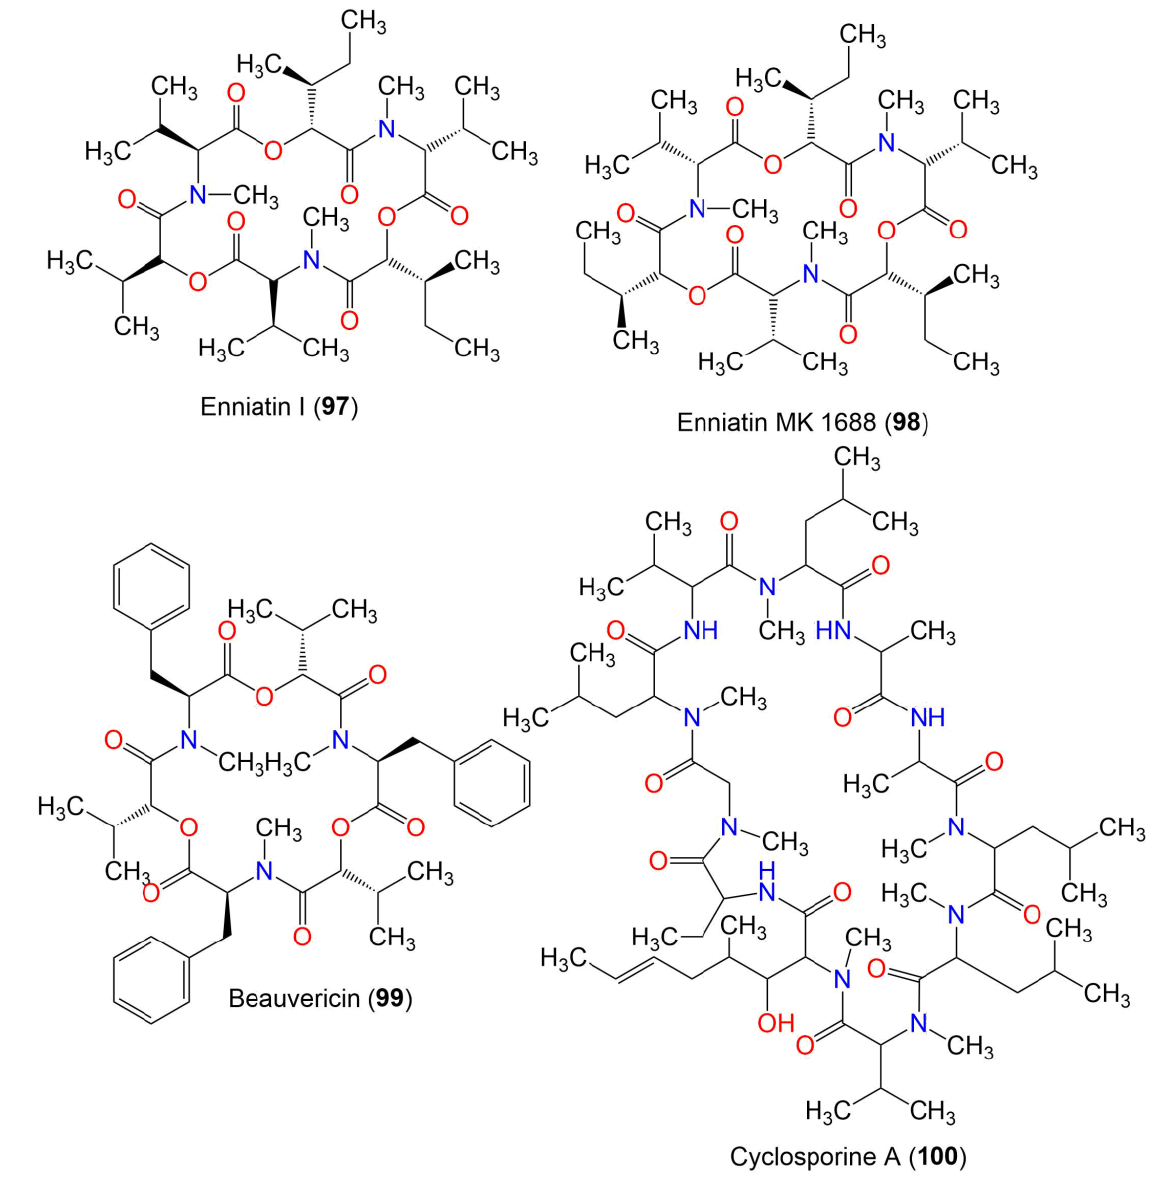
Figure 10. Structures of cyclic depsipeptides ( 97 – 99 ) and cyclic peptide ( 100 ) isolated from F. oxysporum .